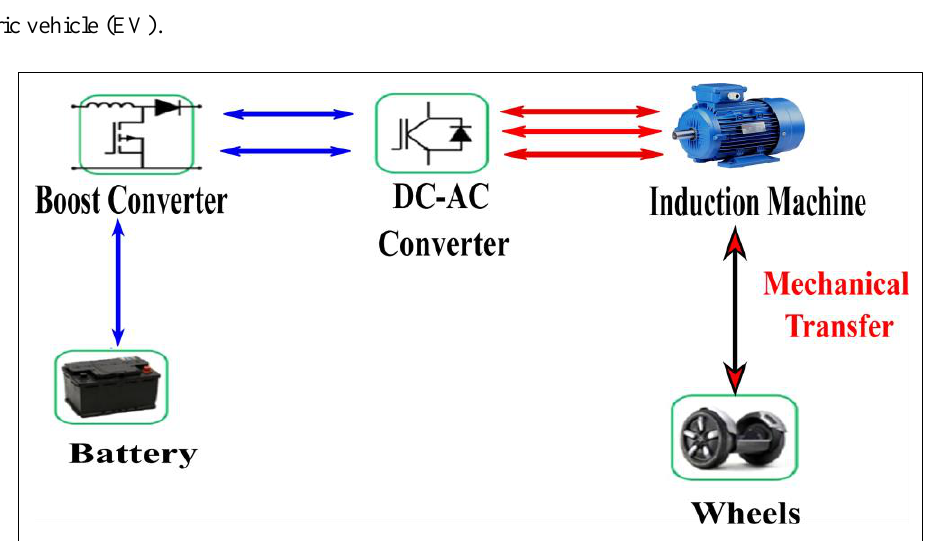
Figure 1. Energy conversion